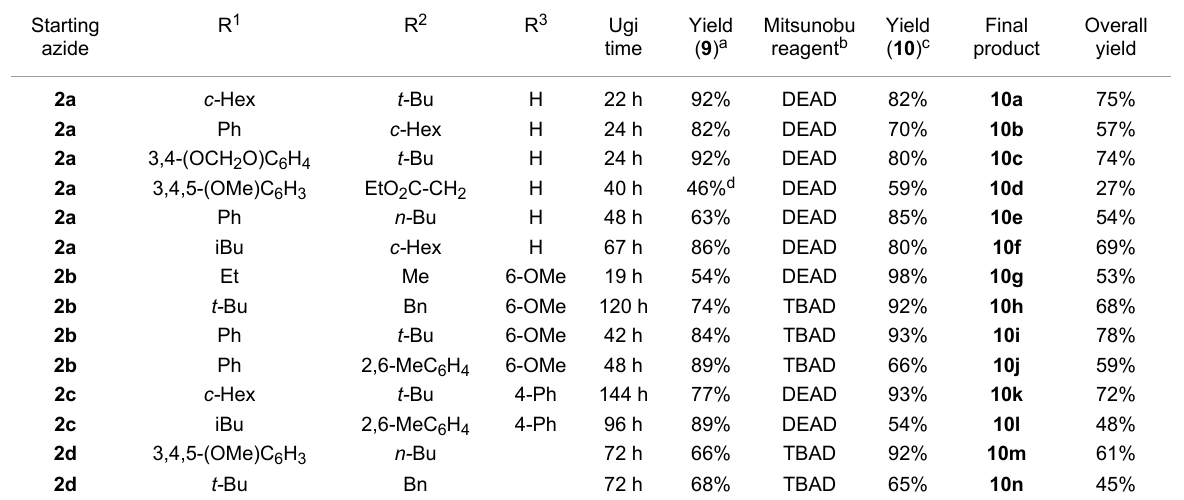
Table 1: Scope of the synthesis of 2,3-dihydrobenzo[ f ][1,4]oxazepin-3-ones 10 . Starting